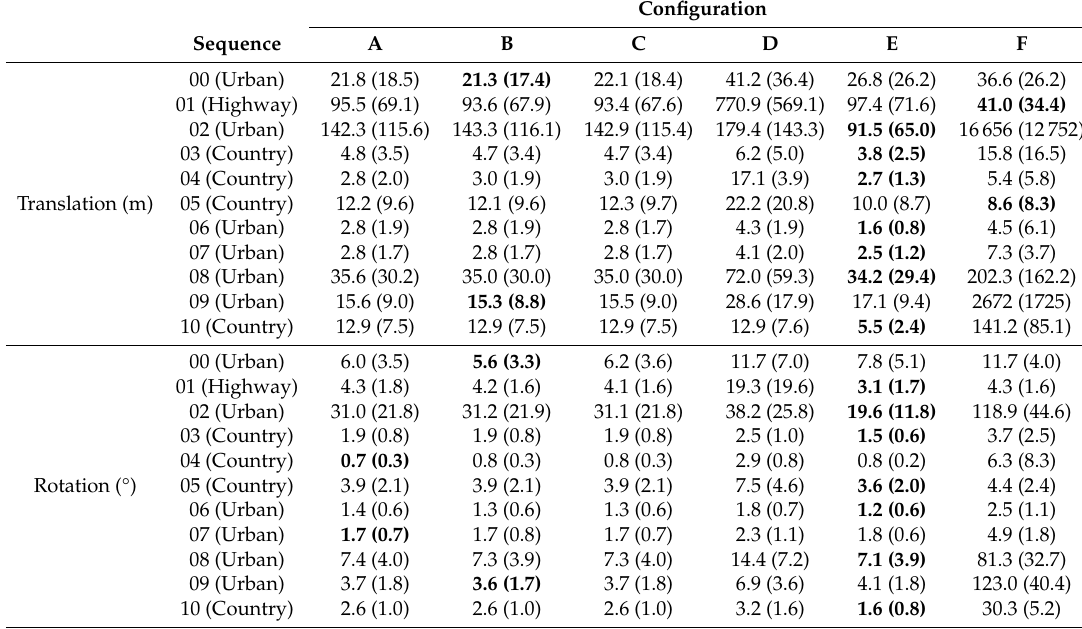
Table 1. Absolute Pose Error (APE) on the different KITTI odometry sequences for each